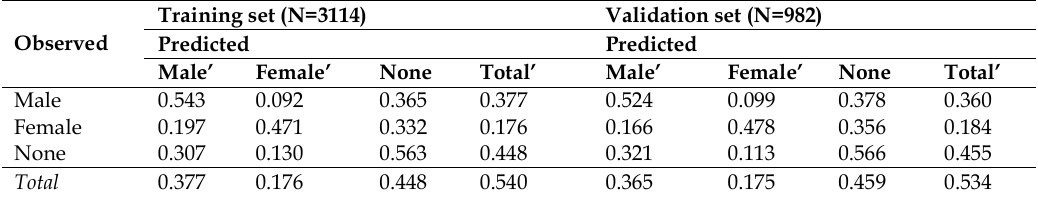
Table 8. Confusion matrix for the training and validation sets